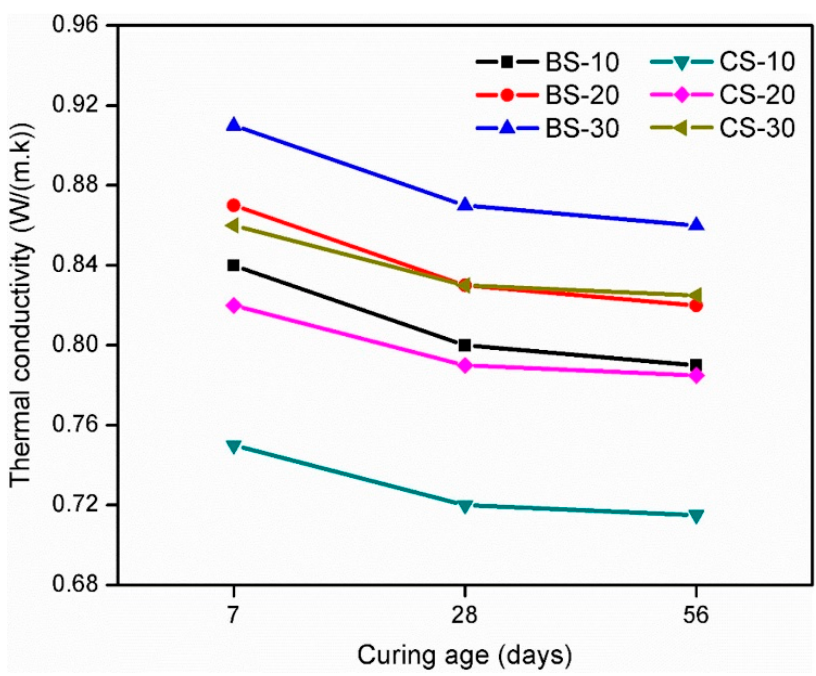
Figure 2. Thermal conductivity .